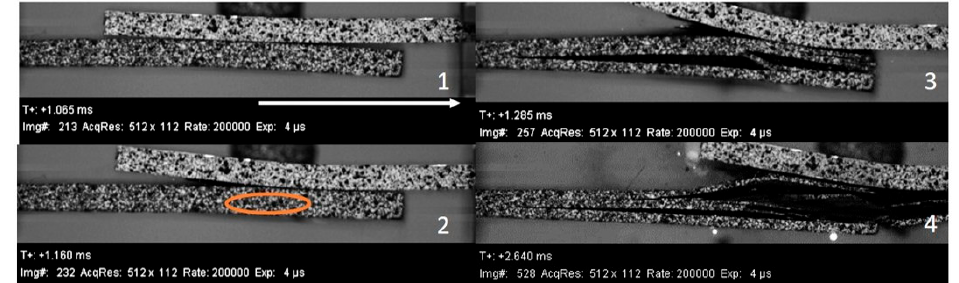
Figure 8. Failure sequence of the multi-material bolted joint BT-M05. (Supplementary Material Video S1).